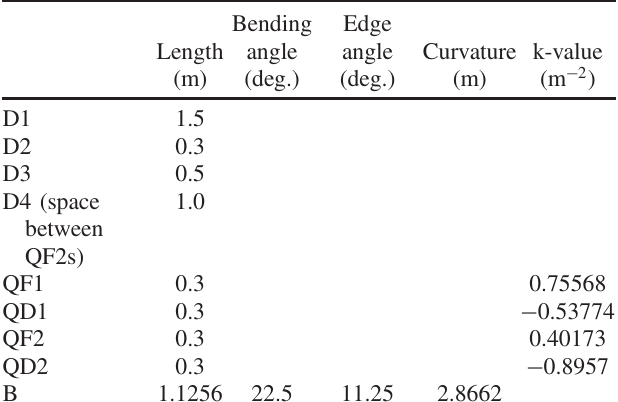
TABLE II. Parameters of the lattice.